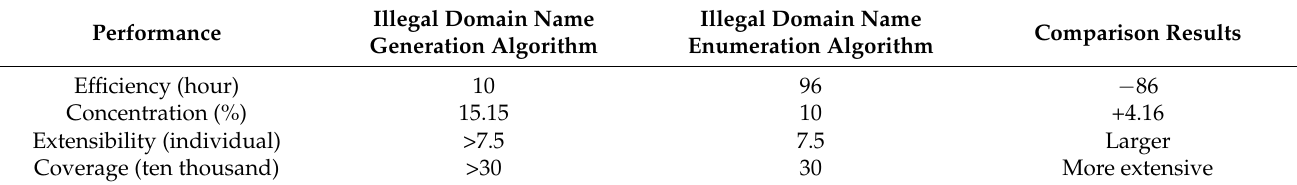
Table 2. Performance comparison table of the algorithm and illegal domain name enumeration algorithm in various